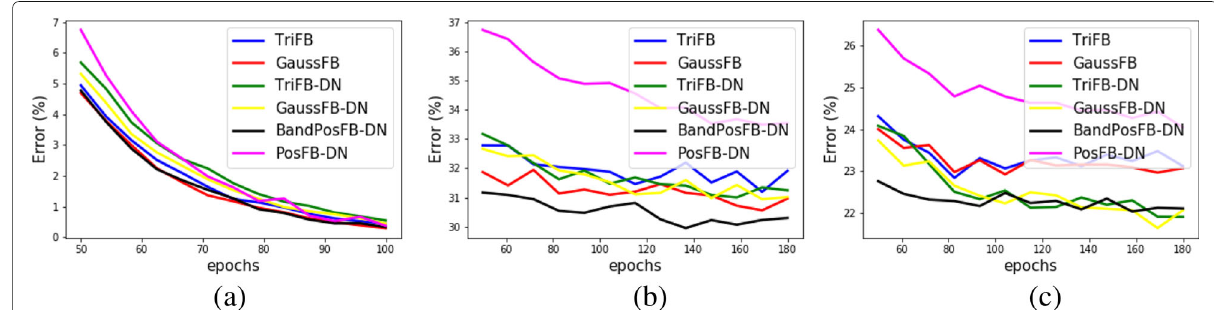
Fig. 9 Training and validation curves on DCASE2016 dataset. a 1-s clip classification error on training set. b 1-s clip classification error on validation set. c 30 s audio classification error on validation